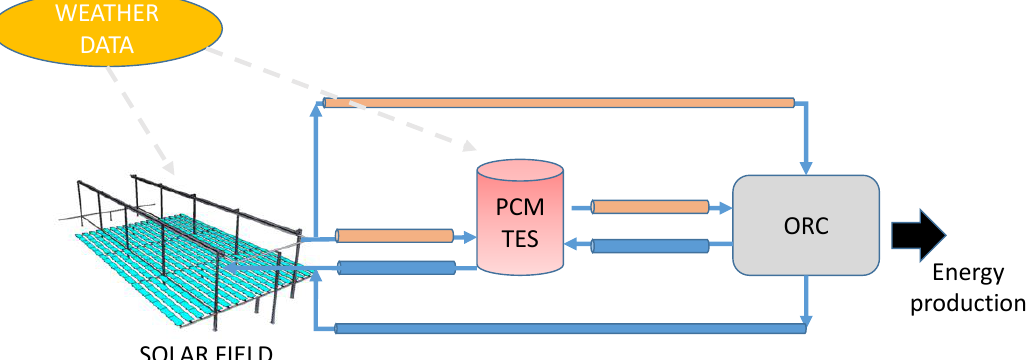
Figure 2. Conceptual schematics of the micro-solar organic Rankine cycle (ORC) plant.